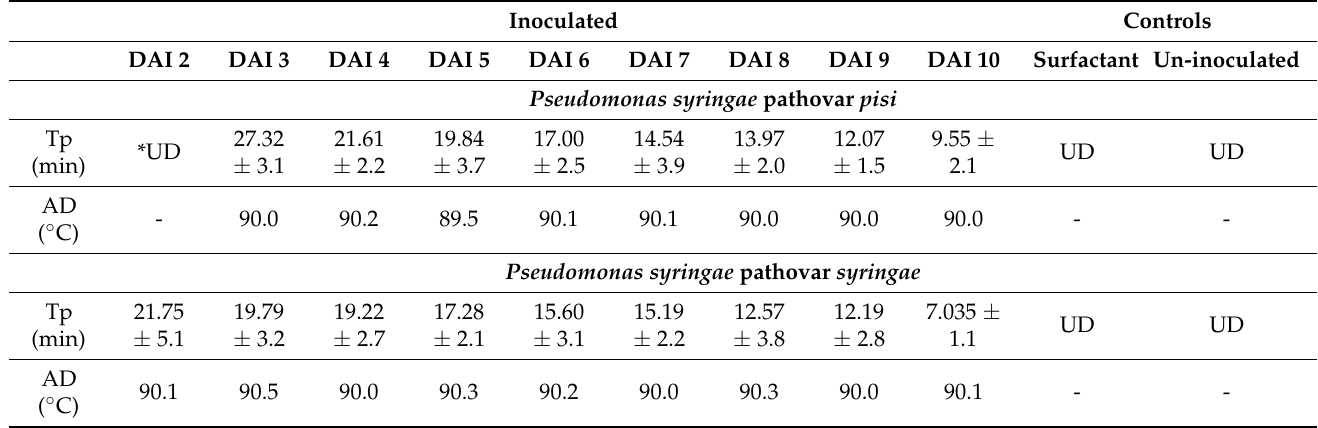
Plants were inoculated with Psp and Pss isolates separately. Samples were taken each day after inoculation (DAI). Tp (Time to positive), AD (anneal derivative), UD (undetected).